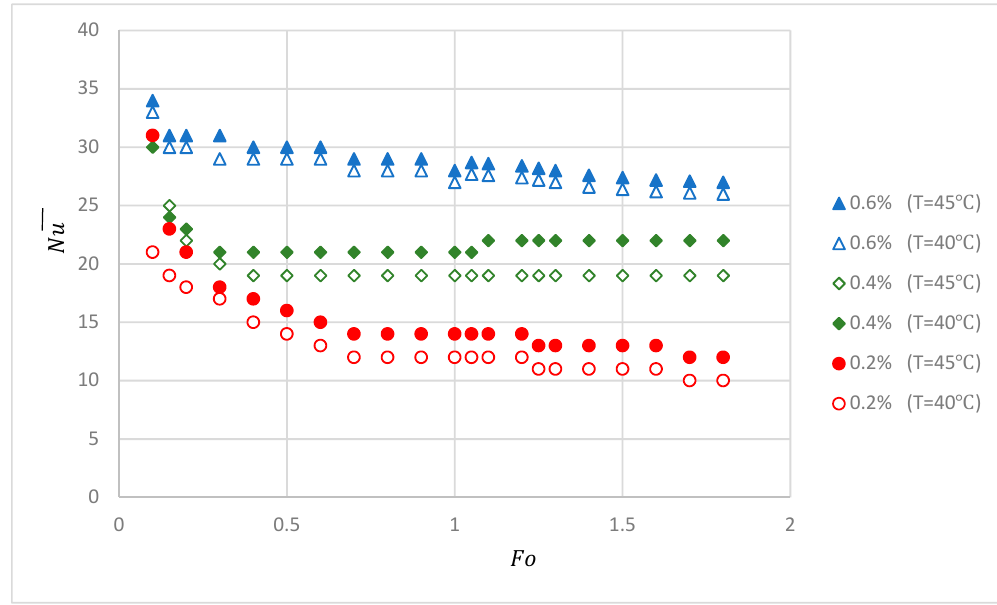
Figure 8. Efficacy of hot wall temperature on the average Nusselt number. Figure 8. E ffi cacy of hot wall temperature on the average Nusselt number.